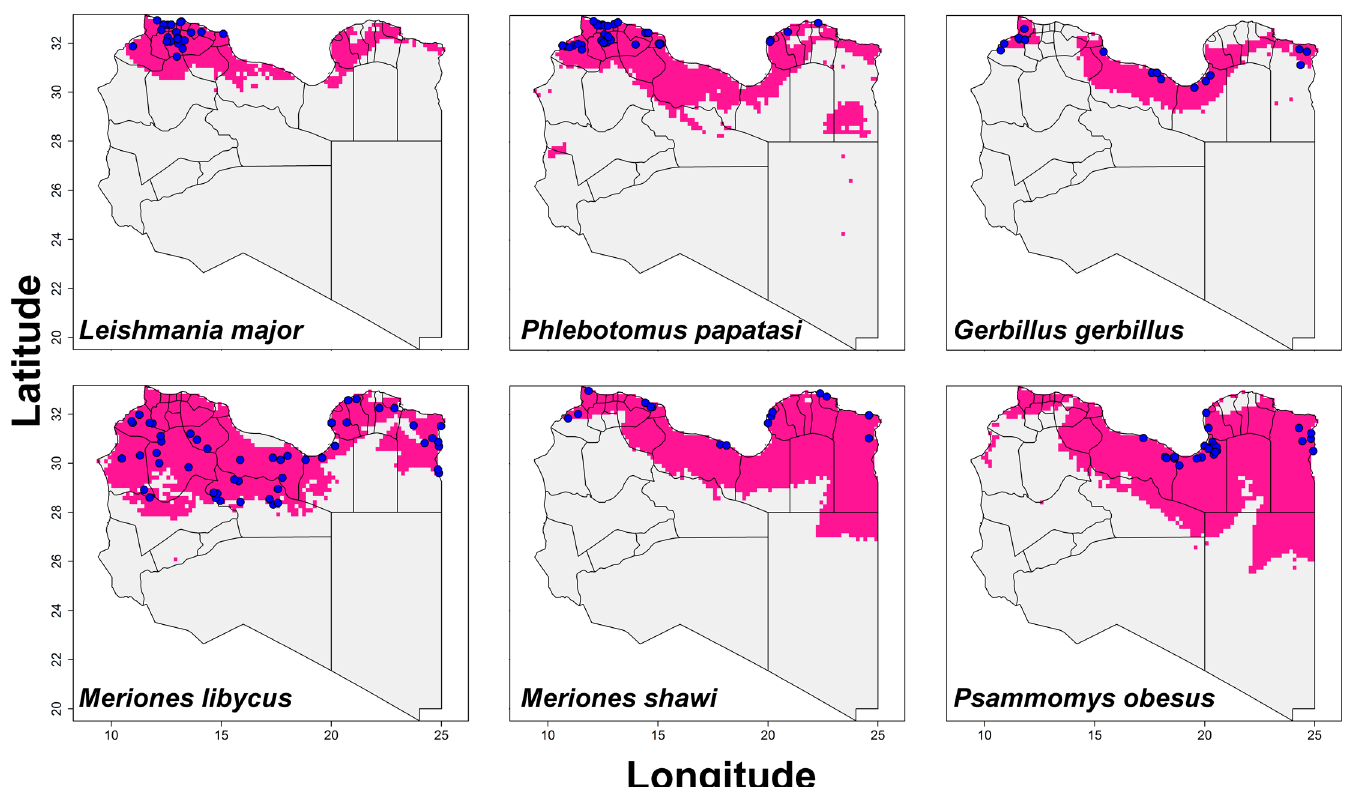
Fig 1. Thresholded potential distribution maps for Leishmania major , Phlebotomus papatasi , and four candidate mammal reservoir species potentially associated with the zoonotic transmission of cutaneous leishmaniasis. Models were calibrated across sampled areas (S), and transferred across all Libya. Blue points are occurrences, pink areas are modeled suitable conditions, and gray areas are unsuitable conditions.